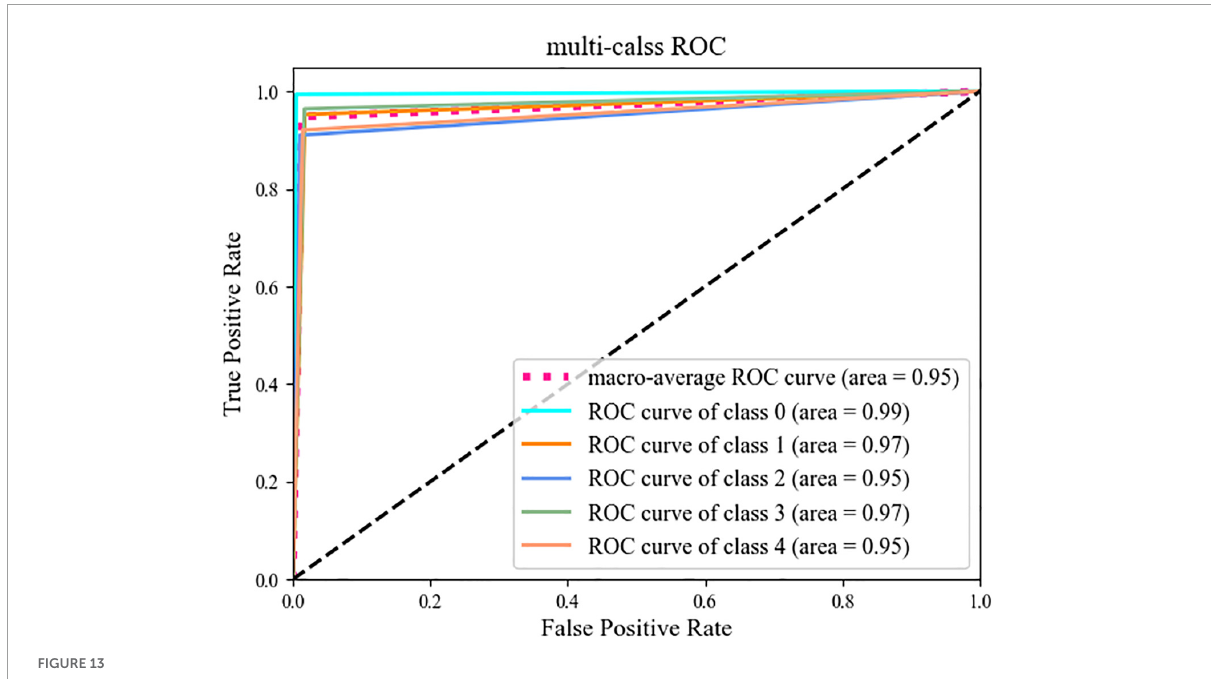
FIGURE13 ROC curve.